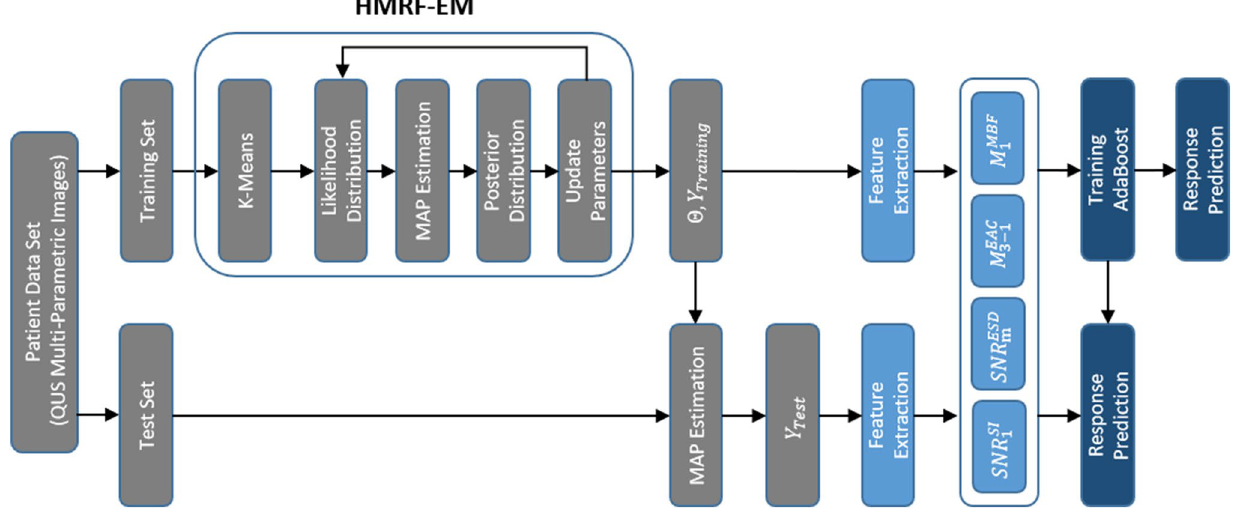
Figure 1. Overall diagram of the proposed framework for identification of intra-tumor regions on QUS multi- parametric images and therapy response